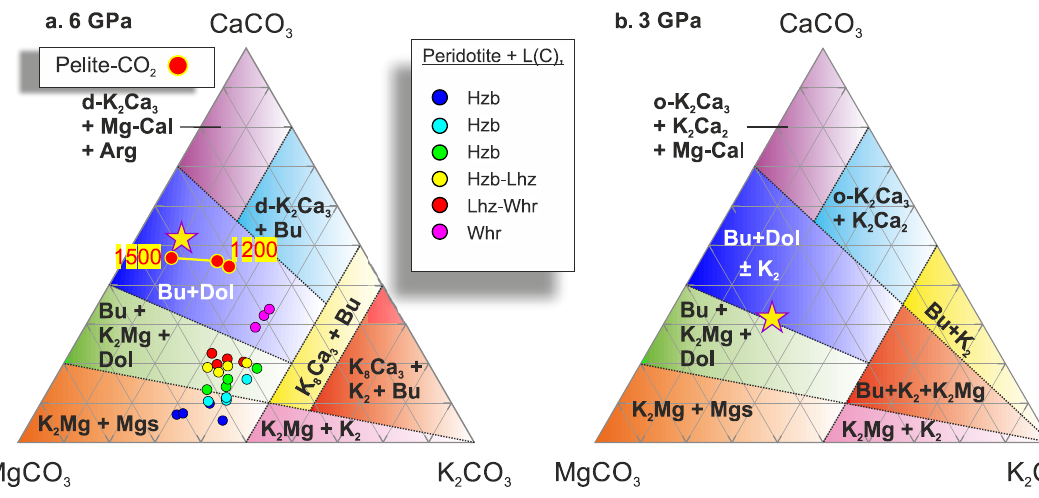
Figure 4. Assemblages of quench products at 6 ( a ) and 3 ( b ) GPa. Stars—carbonatite melt inclusion was reported by [1] ( a ) and [5] ( b ). Carbonatite melts from the complex systems: pelite-CO 2 [36], lherzolite + L(C) with Ca#10−40 [37] .